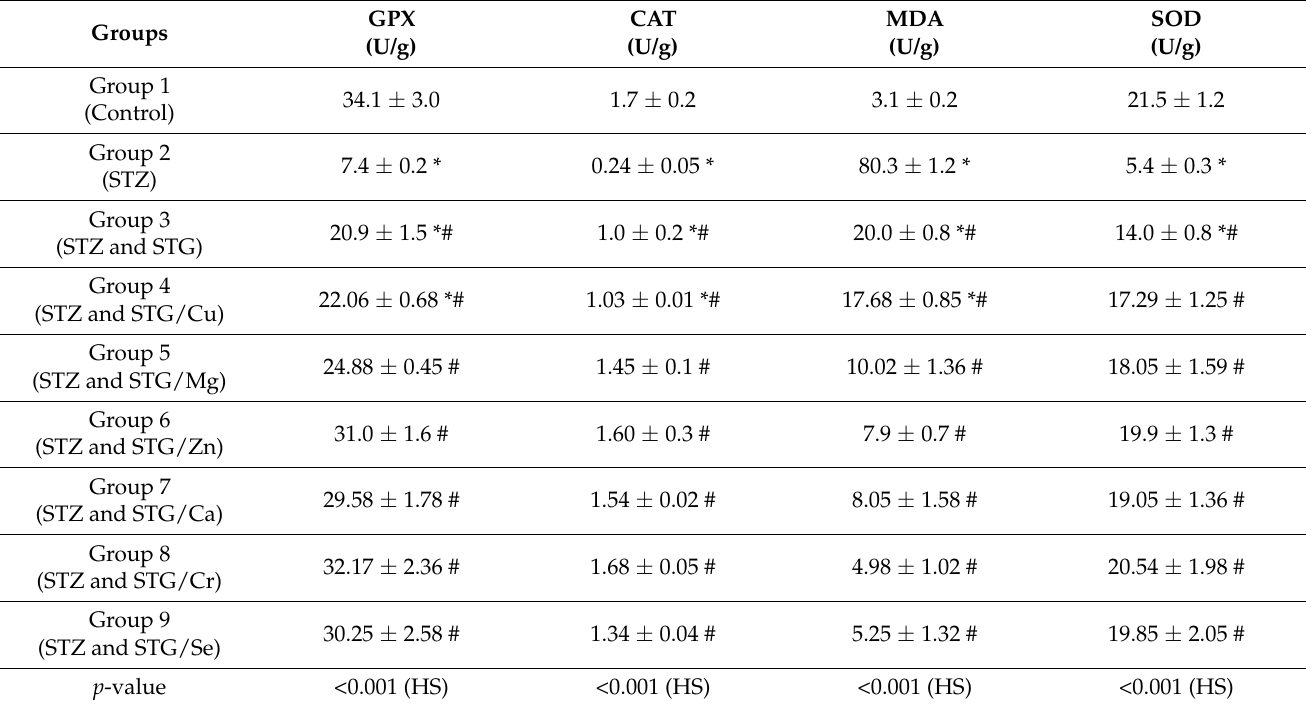
Table 5. Comparison of the studied groups in pancreatic GPX, CAT, MDA, and SOD